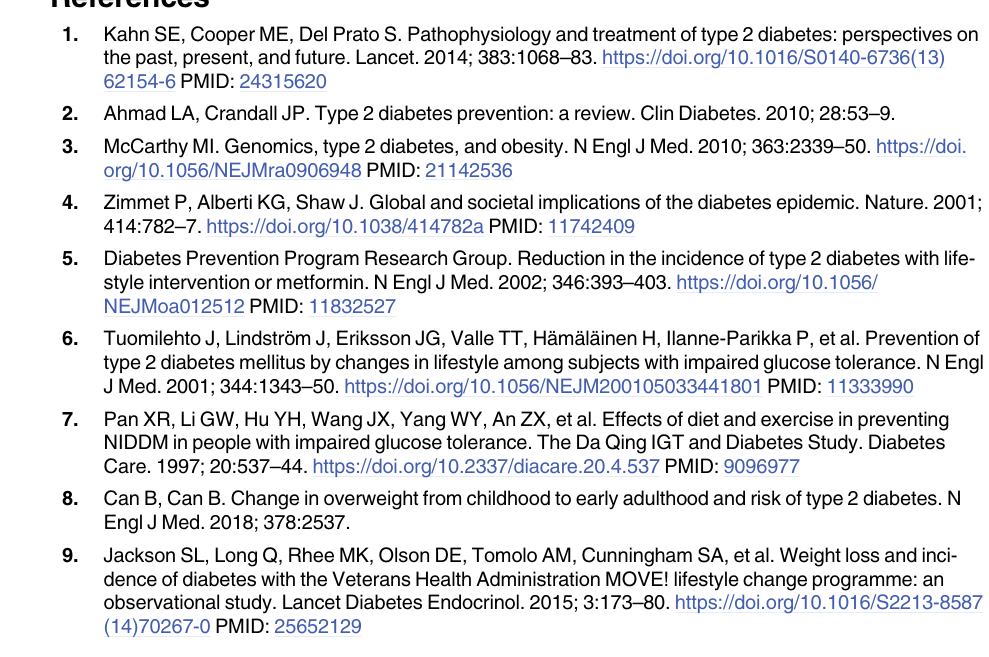
S3 Table. The results of Table 2 using MR–Egger regression instead of inverse-variance- weighted MR. S4 Table. MR–Egger intercept test p